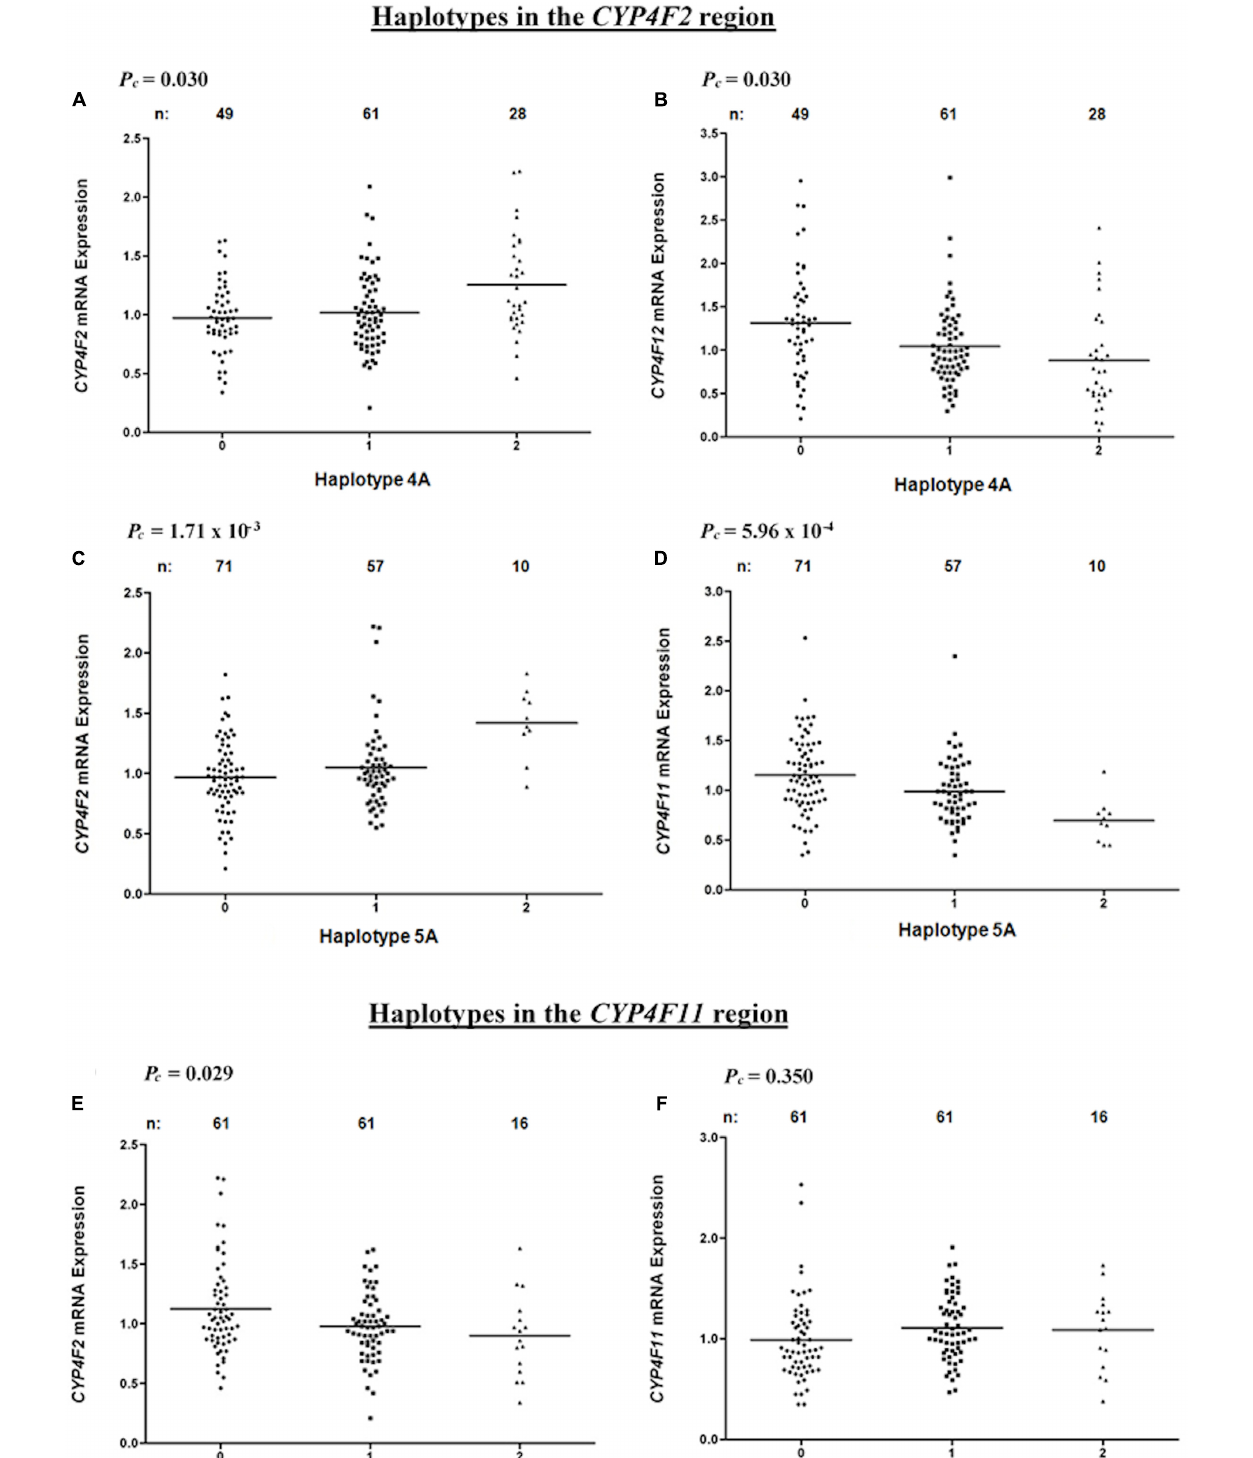
Frontiers in Pharmacology |